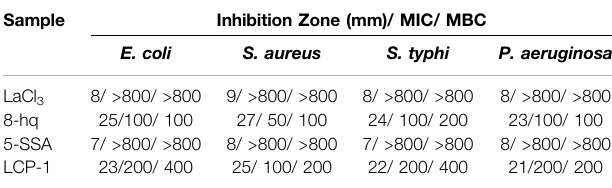
TABLE 1 | ZOI, MIC, and MBC of the composites and their reactants. Sample